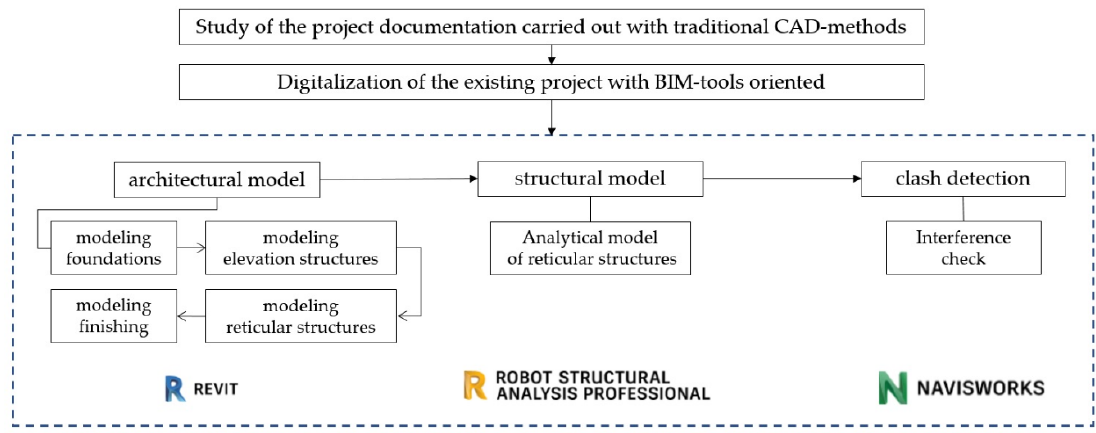
Figure 1. Process methodology overview.